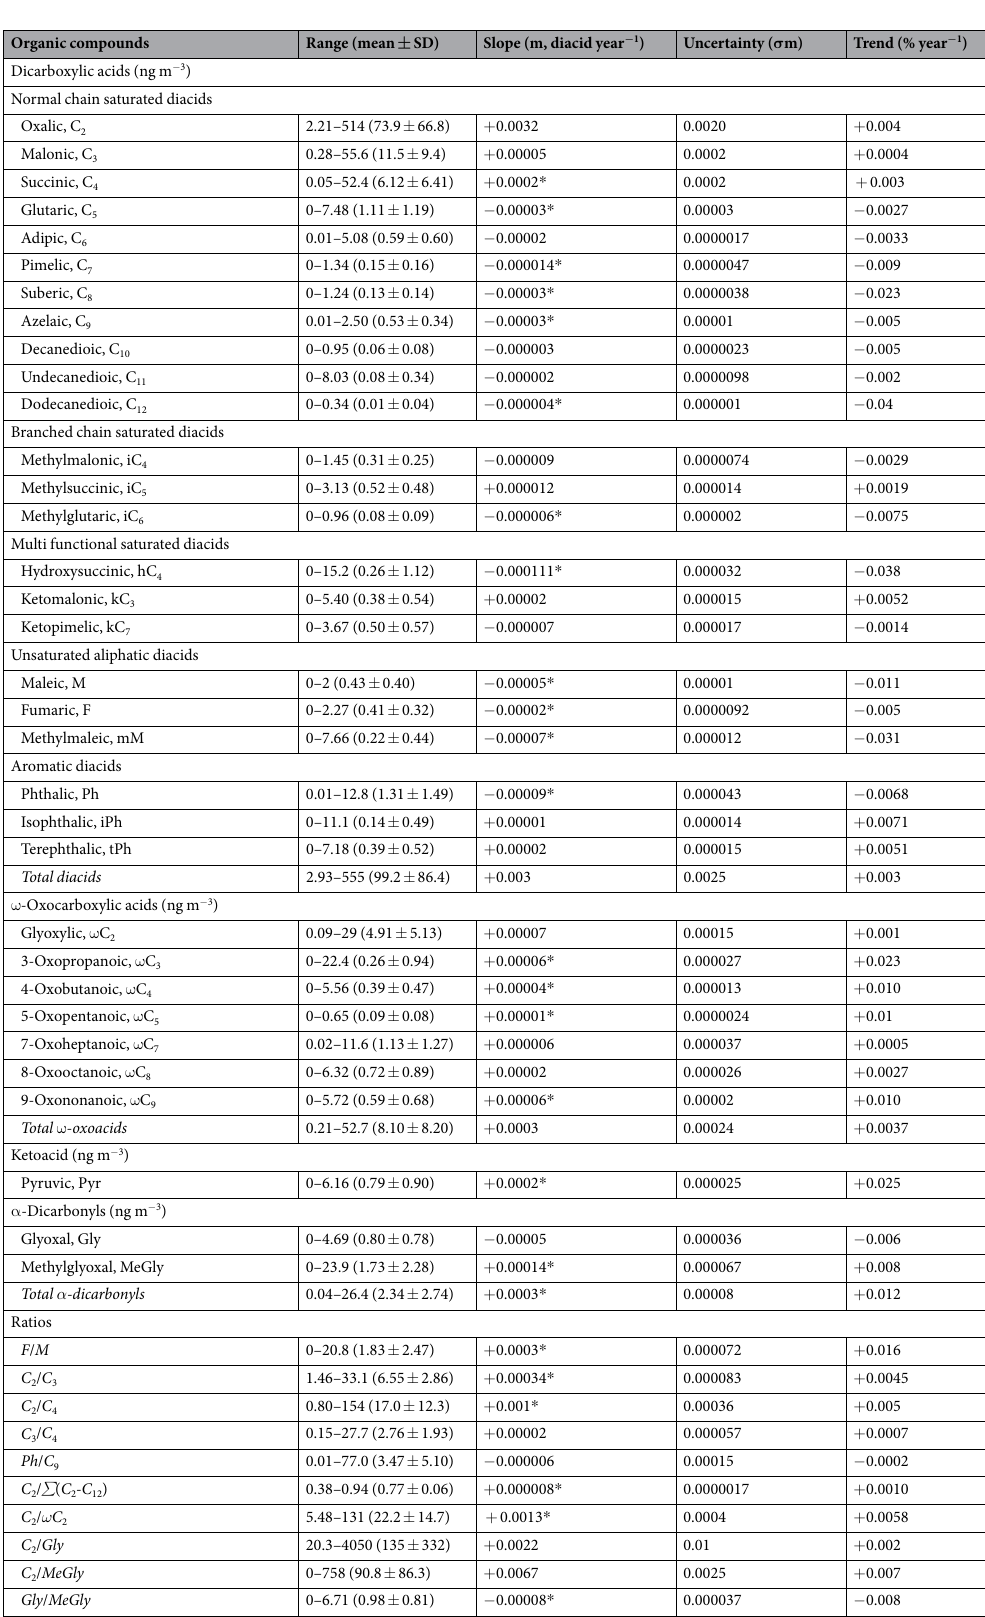
Table 1. Regression statistics (range, mean ± SD, and slope) of water-soluble dicarboxylic acids and related compounds (n = 607) in remote marine TSP aerosols collected at Chichijima Island during the period of 2001 to 2013. The symbol, * , indicates the trends are significant at a 95% (p < 0.05) confidence